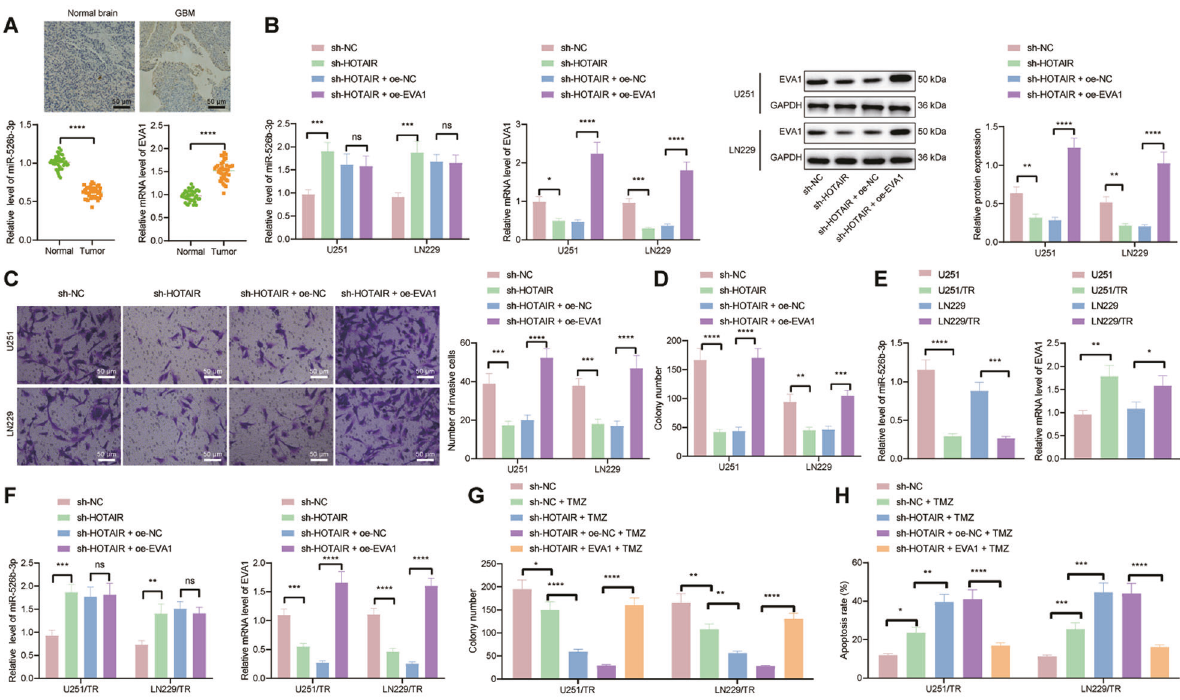
Fig. 5 HOTAIR accelerates GBM progression and increases TMZ resistance by regulating the miR-526b-3p/EVA1 axis. A miR-526b-3p expression detected by RT-qPCR and EVA1 mRNA and positive expression detected by RT-qPCR and immunohistochemistry in clinical tissues of GBM patients ( n = 40) and normal brain tissues ( n = 40). * p < 0.05, compared with normal brain tissues. B miR-526b-3p expression detected by RT-qPCR and EVA1 mRNA and protein expression detected by RT-qPCR and western blot analysis in U251 and LN229 cells treated with sh- HOTAIR or combined with oe-EVA1. C Invasion of U251 and LN229 cells treated with sh-HOTAIR or combined with oe-EVA1 measured by Transwell assay. D Colony formation of U251 and LN229 cells treated with sh-HOTAIR or combined with oe-EVA1 measured by colony formation assay. E RT-qPCR detection of miR-526b-3p and EVA1 expression in U251/TR and LN229/TR cells as well as parental cells U251 and LN229. F RT-qPCR detection of miR-526b-3p and EVA1 expression in U251/TR and LN229/TR cells treated with sh-HOTAIR or combined with oe-EVA1. G Colony formation of U251/TR and LN229/TR cells treated with sh-HOTAIR or combined with oe-EVA1 measured by colony formation assay. H Flow cytometric analysis of U251/TR and LN229/TR cell apoptosis upon treatment with sh-HOTAIR or combined with oe- EVA1. * p < 0.05, ** p < 0.01, *** p < 0.001, or **** p < 0.0001. ns indicates no signi fi cant difference between the two groups. Each experiment was repeated three times